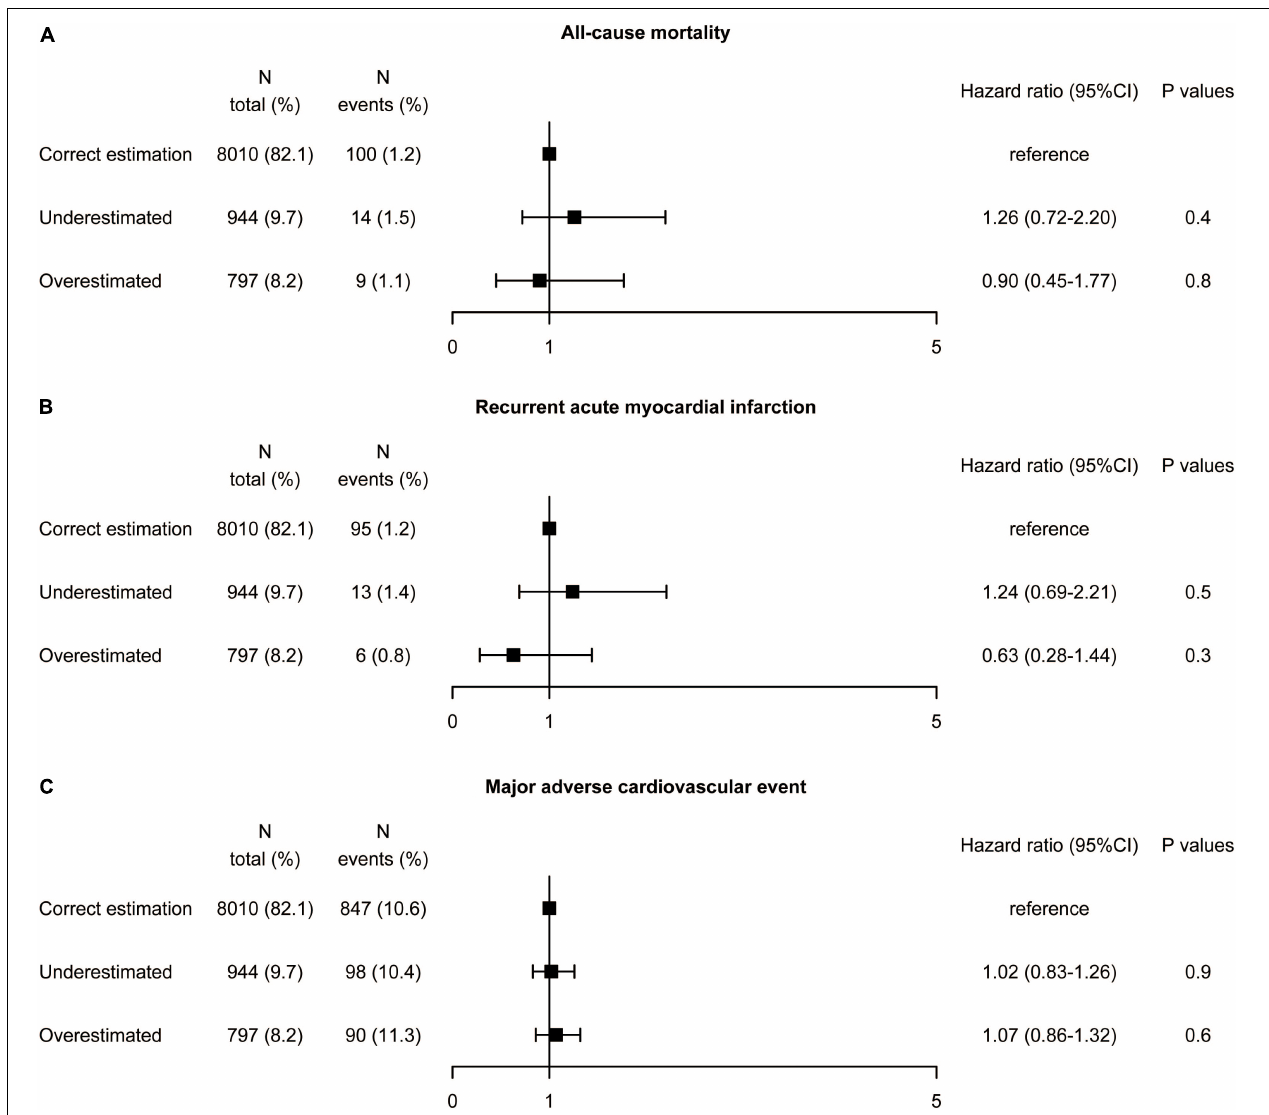
FIGURE 3 | Association between misclassification by the Martin equation and the risk of (A) all-cause mortality, (B) recurrent acute myocardial infarction, and (C) major adverse cardiovascular event by univariate analysis. Hazard ratios were from Cox proportional hazards regressions with univariable analysis. CI, confidence